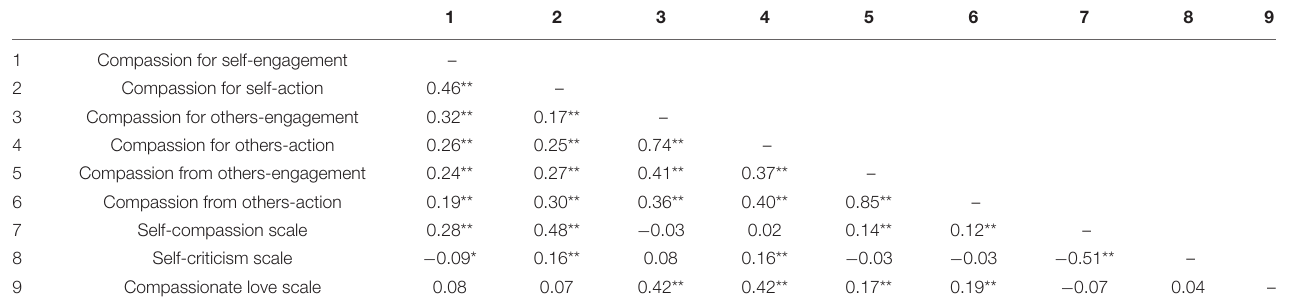
TABLE 1 | Pearson product-moment correlation